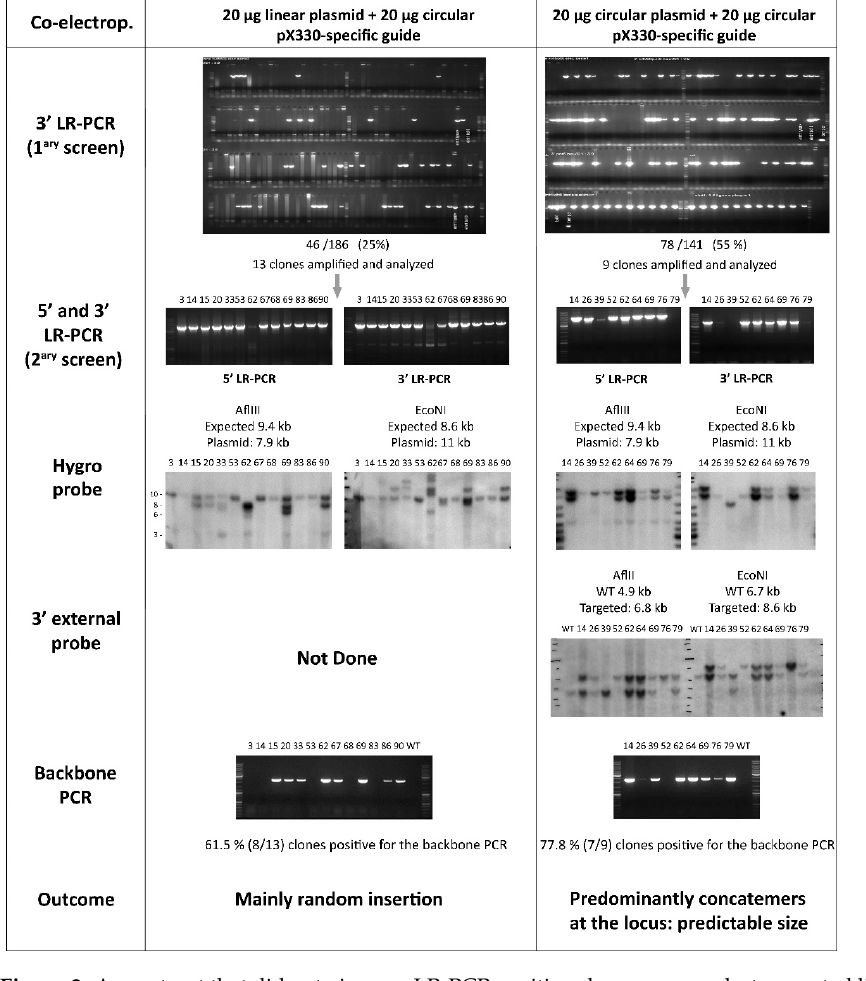
Figure 2. A construct that did not give any LR-PCR positive clones was co-electroporated linear (20 µg) and circular (20 µg) plasmids the same day in ESCs. The same CRISPR plasmid was used (20 µg) for both electroporation. Resistant clones were picked and subcloned, and ESC lysates were screened by 3 ′ LR-PCR (1 ary screen). Twenty five percent clones (46/186 clones screened) were found to be positive when the linearized construct was used; 55% clones (78/141) were positive when the construct was circular. Thirteen clones obtained with the linearized construct were amplified, and all were confirmed by 5 ′ and 3 ′ LR-PCR (clone 62 gave faint PCR products); similarly, nine clones obtained with the circular construct were amplified and eight were confirmed by both 5 ′ and 3 ′ LR- PCR. Amplified ESCs were analyzed by Southern blotting with an internal probe (Hygro probe). A single band at the correct size was expected, the expected sizes for each restriction digests are indi- cated (see Suppl. Figure S1 for detailed schemes). Five clones (3, 14, 53, 68 and 83) show a unique band for each digest when the linear plasmid was electroporated and two clones (26 and 62) when the circular plasmid was electroporated. Strikingly, the Southern blot pattern of the other (unvali- dated) clones was very predictable when the targeting construct was used as circular and the size of the additional band corresponded to the complete plasmid fragment size (including the plasmid backbone). When the linearized construct was used, numerous additional insertions were observed. A Southern blot probe with a 3 ′ external probe (only performed on clones obtained with a circular construct) showed an expected pattern with a WT band and a targeted band as the expected size. Note that clone 52 could be homozygous (no WT band detected). All clones with an incorrect South- ern blot pattern were also positive for a PCR (5 ′ backbone PCR) specific for the targeting construct